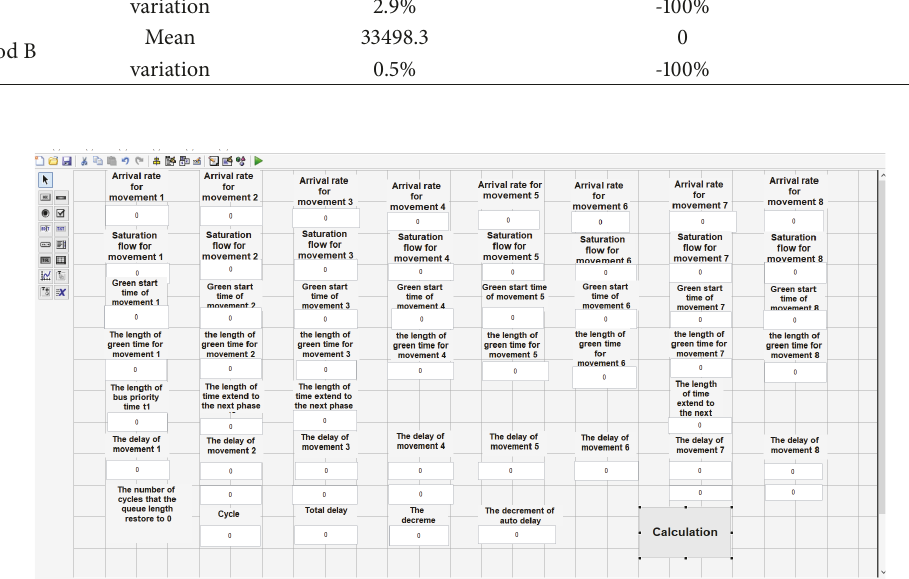
Figure 7: Program running interface.